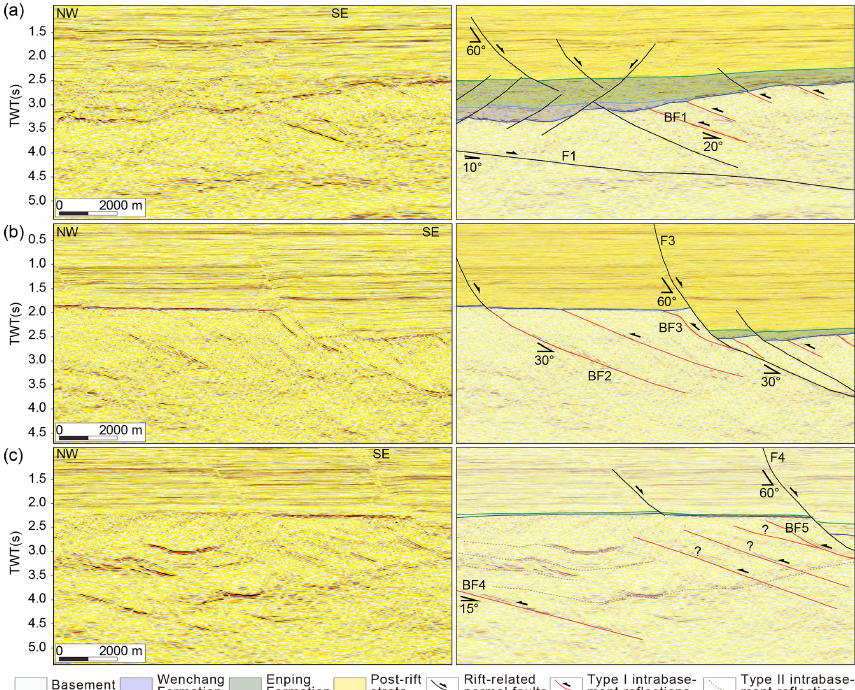
Figure 5. Uninterpreted (left column) and interpreted (right column) cross sections showing the occurrence of intra-basement structures in the study area. Panels (a) and (b) show the characteristics of Type I intra-basement structures, while (c) shows the interpretation of Type II intra-basement structures with a Type I intra-basement structure. A question mark indicates uncertainty in the interpretation. See Fig. 1 for the location of these cross sections. Colours within the sedimentary cover correspond to ages shown within the stratigraphic column (Fig. 2).